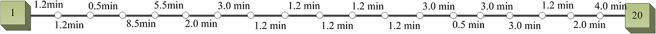
The topological structure of a real life transit route, Line 23 in Dalian.